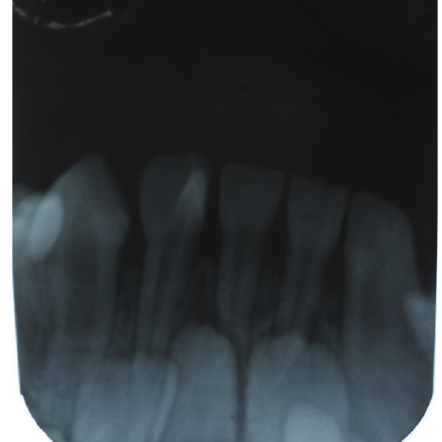
Figure 2: Radiographic image showing pulp extension into the talon